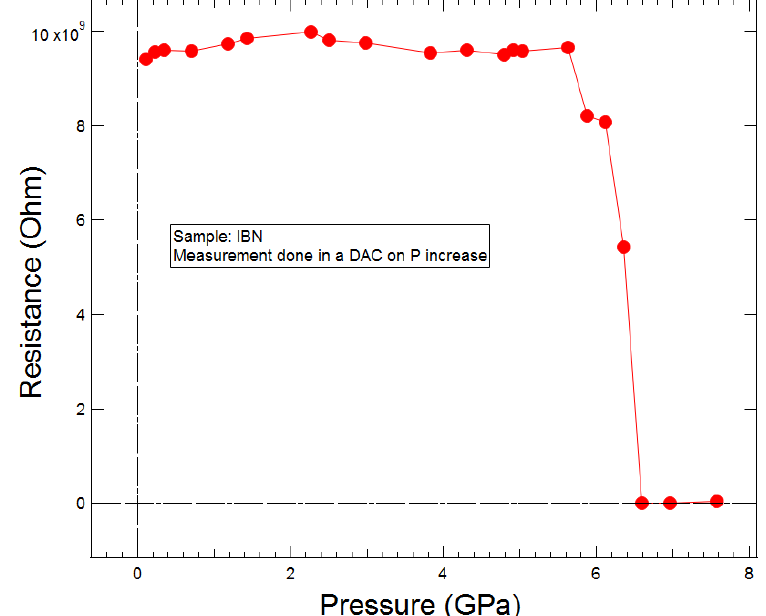
Figure 9. Resistance of polycrystalline 4-iodobenzonitrile as a function of pressure. A drop from 10 10 to 8 × 10 9 Ω occurs at the phase transition. The precipitous drop beyond 6 GPa comes from interference from the gasket.